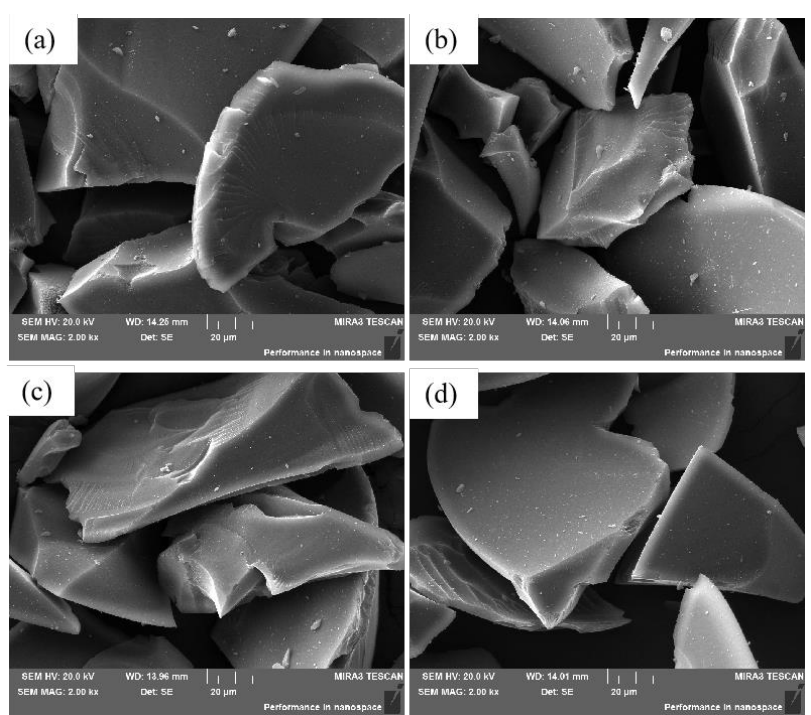
Figure 5. SEM images of different sugar-derived carbons carbonized at 1200 °C. ( a ) Glu − PAM, ( b ) Fru − PAM, ( c ) Mal − PAM, ( d ) Suc − PAM.